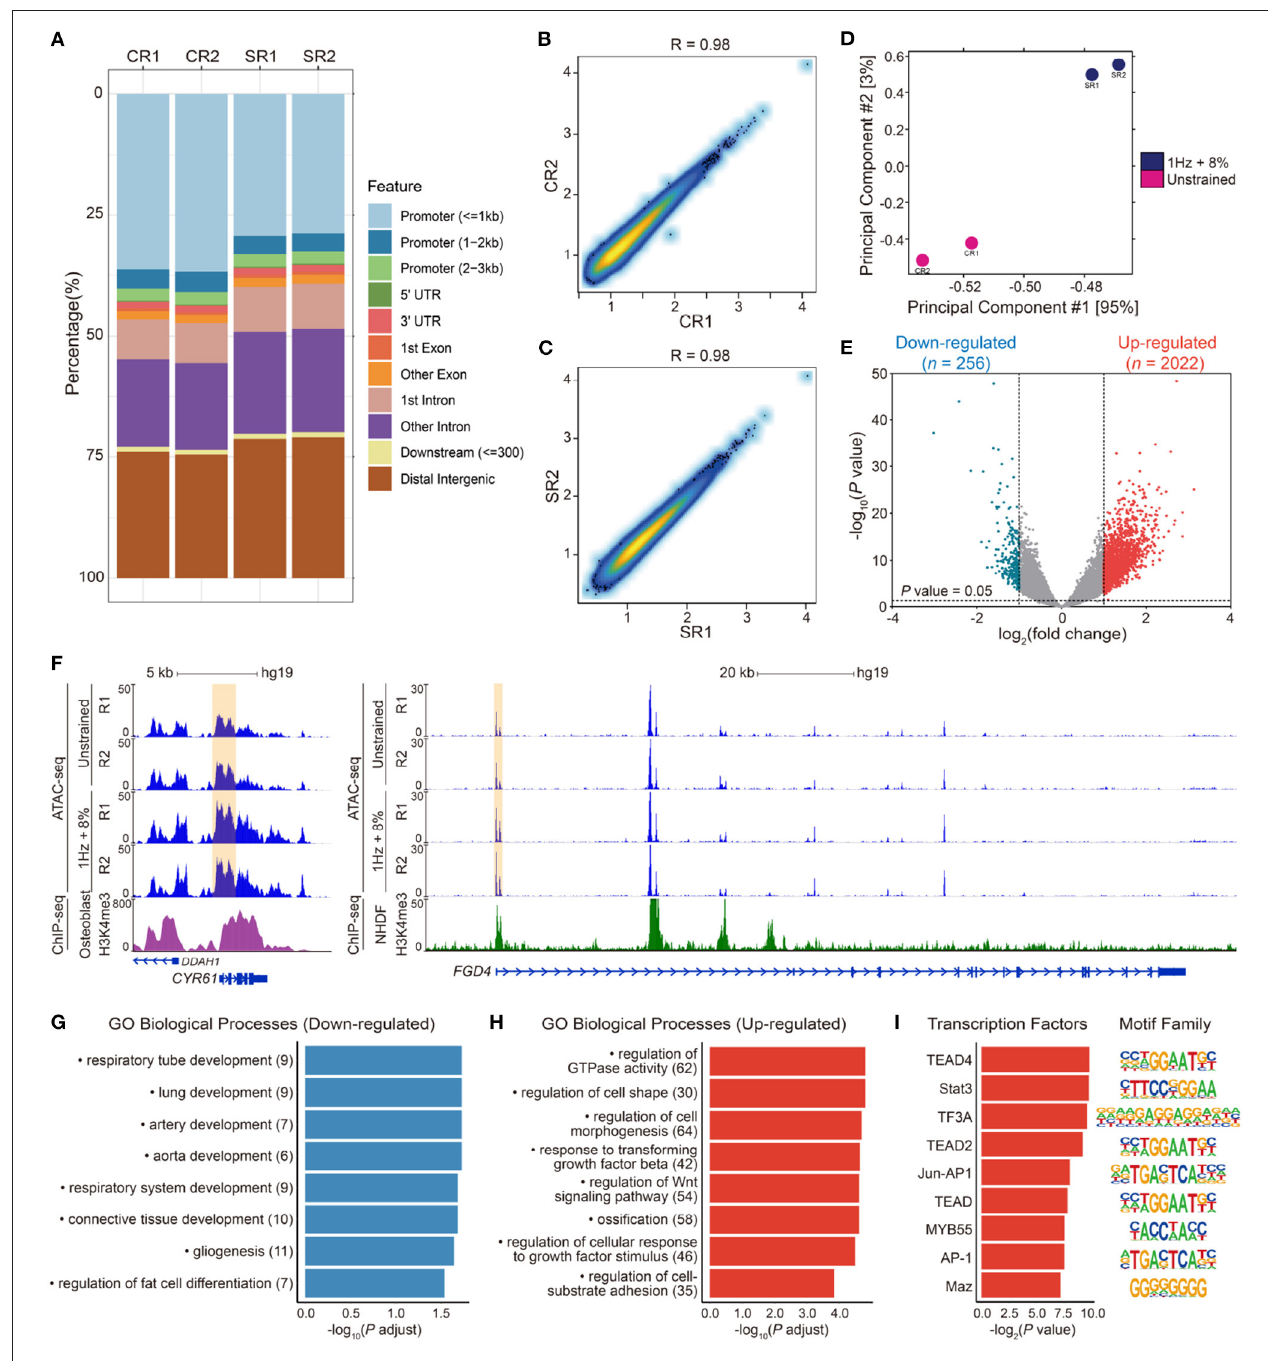
FIGURE 5 | (A) Peaks feature distribution of ATAC-seq samples in unstrained (CR1, CR2) and 1 Hz + 8% stretching (SR1, SR2) groups. More than 25% peaks were enriched in promoter regions in each sample. (B,C) Pearson correlation analysis of replicate samples ATAC-seq data in unstrained (CR1, CR2) and 1 Hz + 8% (SR1, SR2) groups. There was strong correlation between two replicates in both conditions. (D) Principal component analysis (PCA) of chromatin accessibility after cyclic stretching in two dimensions. The red dots indicate two unstrained samples (CR1, CR2), and two blue dots indicate 1 Hz + 8% stretching samples (SR1, SR2). (E) Volcano plots analysis of genes with different openness chromatin sites after 1 Hz + 8% cyclic stretch. A total of 2278 gene loci with log 2 (fold change) > 1 or log 2 (fold change) < -1, were altered significantly based on P value < 0.05. Among them, 2022 red dots stand for upregulate gene loci, and 256 blue dots stand for downregulate gene loci. Dotted lines in x -axis stand for log 2 (fold change) = ± 1 and dotted line in y -axis stands for P value = 0.05. (F) Normalized epigenetic profiles at CYR61 (ch1: 86046444-86049648) and FGD4 (ch12: 32655041-32798984) loci in unstrained and 1 Hz + 8% stretching groups. H3K4me3 ChIP-seq profiles of human osteoblasts at CYR61 loci and normal human dermal fibroblasts (NHDF) at FGD4 loci were shown below. The yellow highlighted regions represented promoter